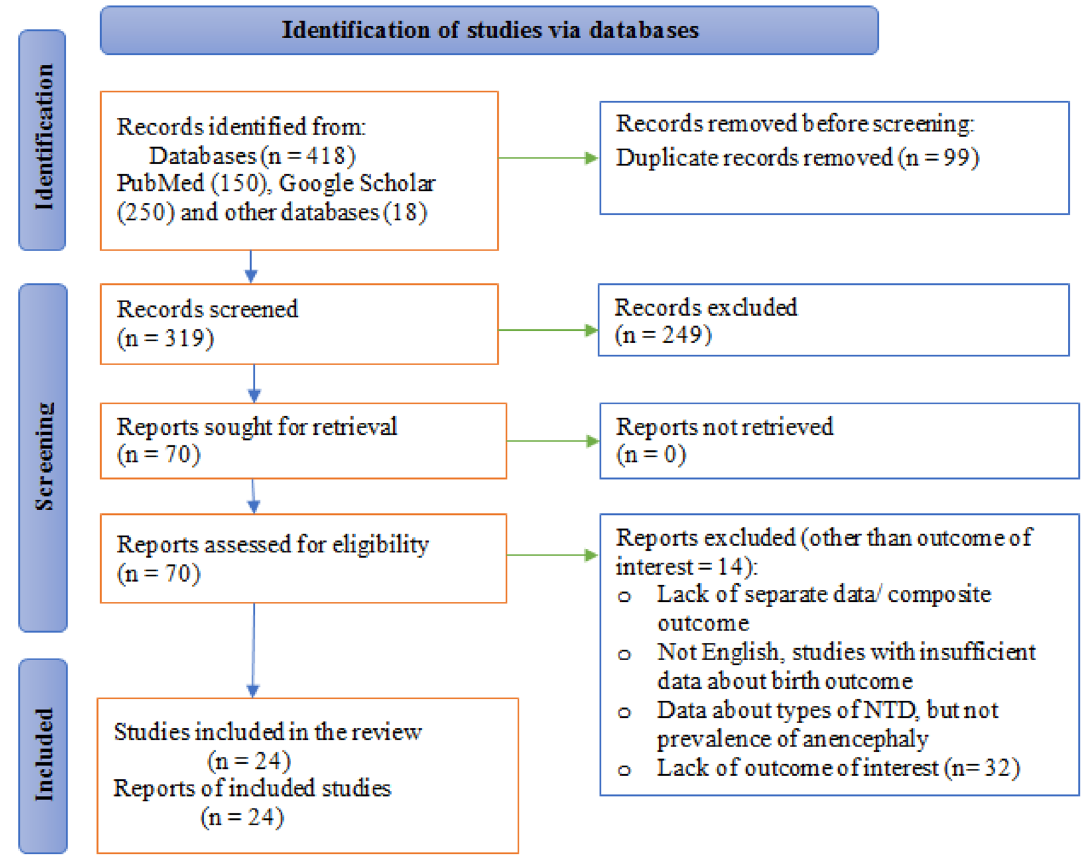
Figure 1. Study selection flow diagram based on the PRISMA 2020 statement: an updated guideline for reporting systematic reviews 19